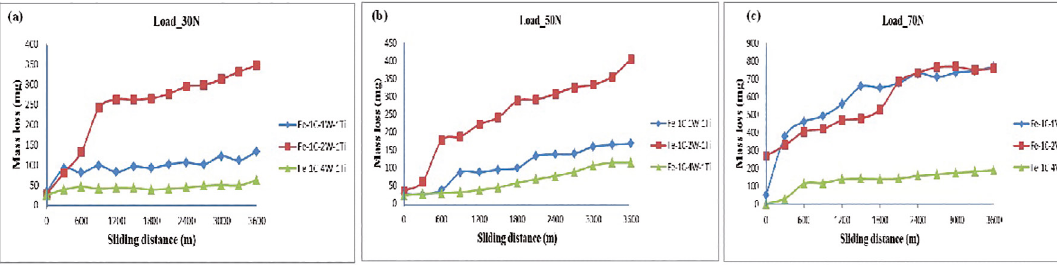
Figure 3. Dry sliding wear behaviour ofhot extruded P/M low alloy steel at different loads (a) 30N; (b) 50N; (c)